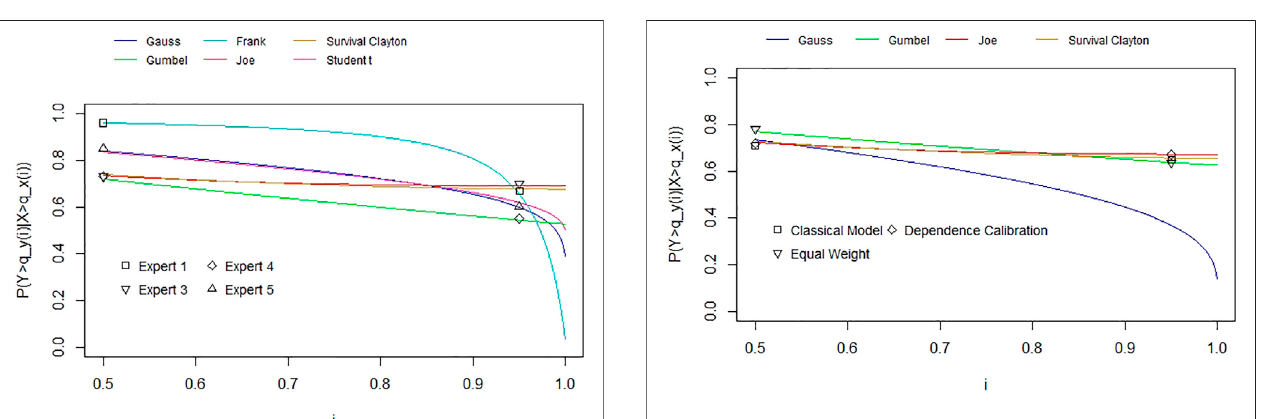
FIGURE 7 | Combined conditional scenario of all experts for Escherichia coli resistance to Carbapenems in the United Kingdom in